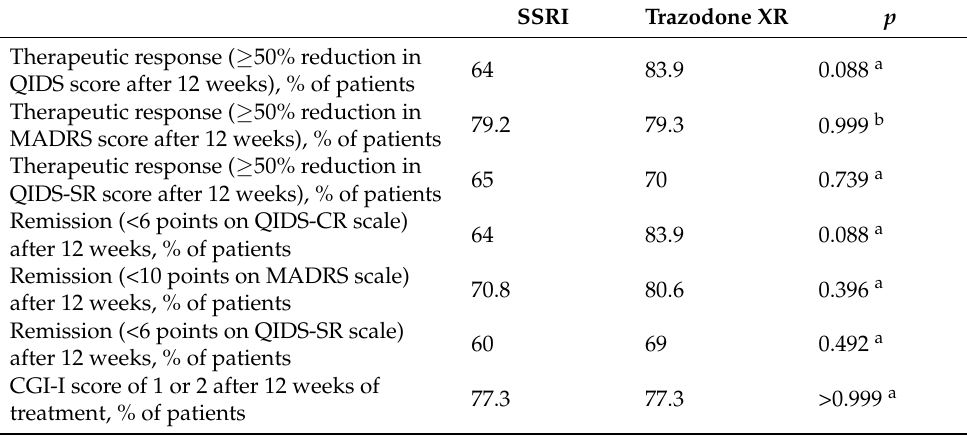
Table 6. Comparison of the frequencies of therapeutic response, remission (measured by QIDS, QIDS-SR, and MADRS scores) and clinical improvement (measured by CGI-I score) between the patients treated with SSRIs and those treated with trazodone XR after 12 weeks of treatment. MADRS—Montgomery– Åsberg Depression Rating Scale; QIDS-CR—Quick Inventory of Depressive Symptomatology, clinician rating; QIDS-SR—Quick Inventory of Depressive Symptomatology, self rating; and CGI—Clinical Global Impression